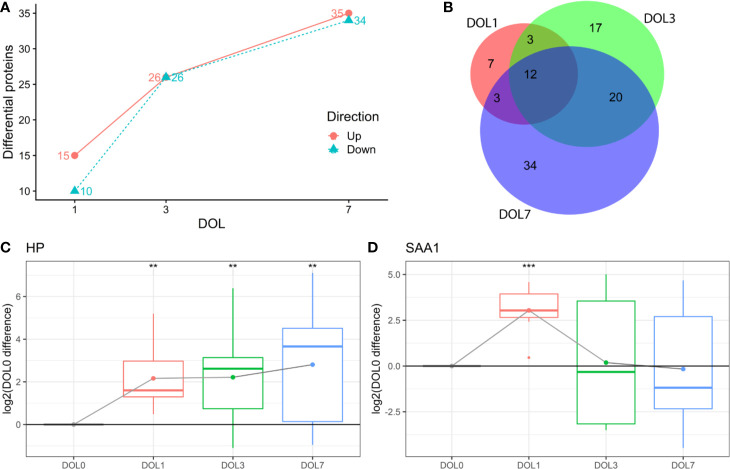
Differentially abundant plasma proteins (q-value < 0.05) compared to day of life (DOL) 0. (A) We identified a robust trajectory of differentially expressed proteins over the first week of life. (B) Overlap of regulated proteins. Protein regulations of (C) Haptoglobin (HP). (D) Serum amyloid A1 (SAA1) normalized to DOL0, with mean abundance difference indicated by dots connected with a line. q-value * <0.05, **: <0.01, ***: <0.001.